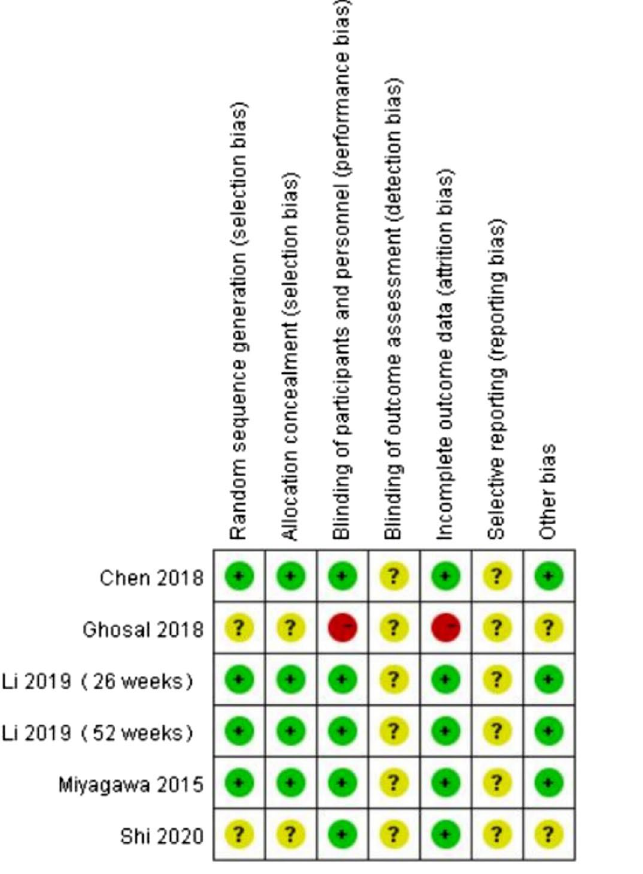
Figure 2. Quality assessment for risk of bias for studies.